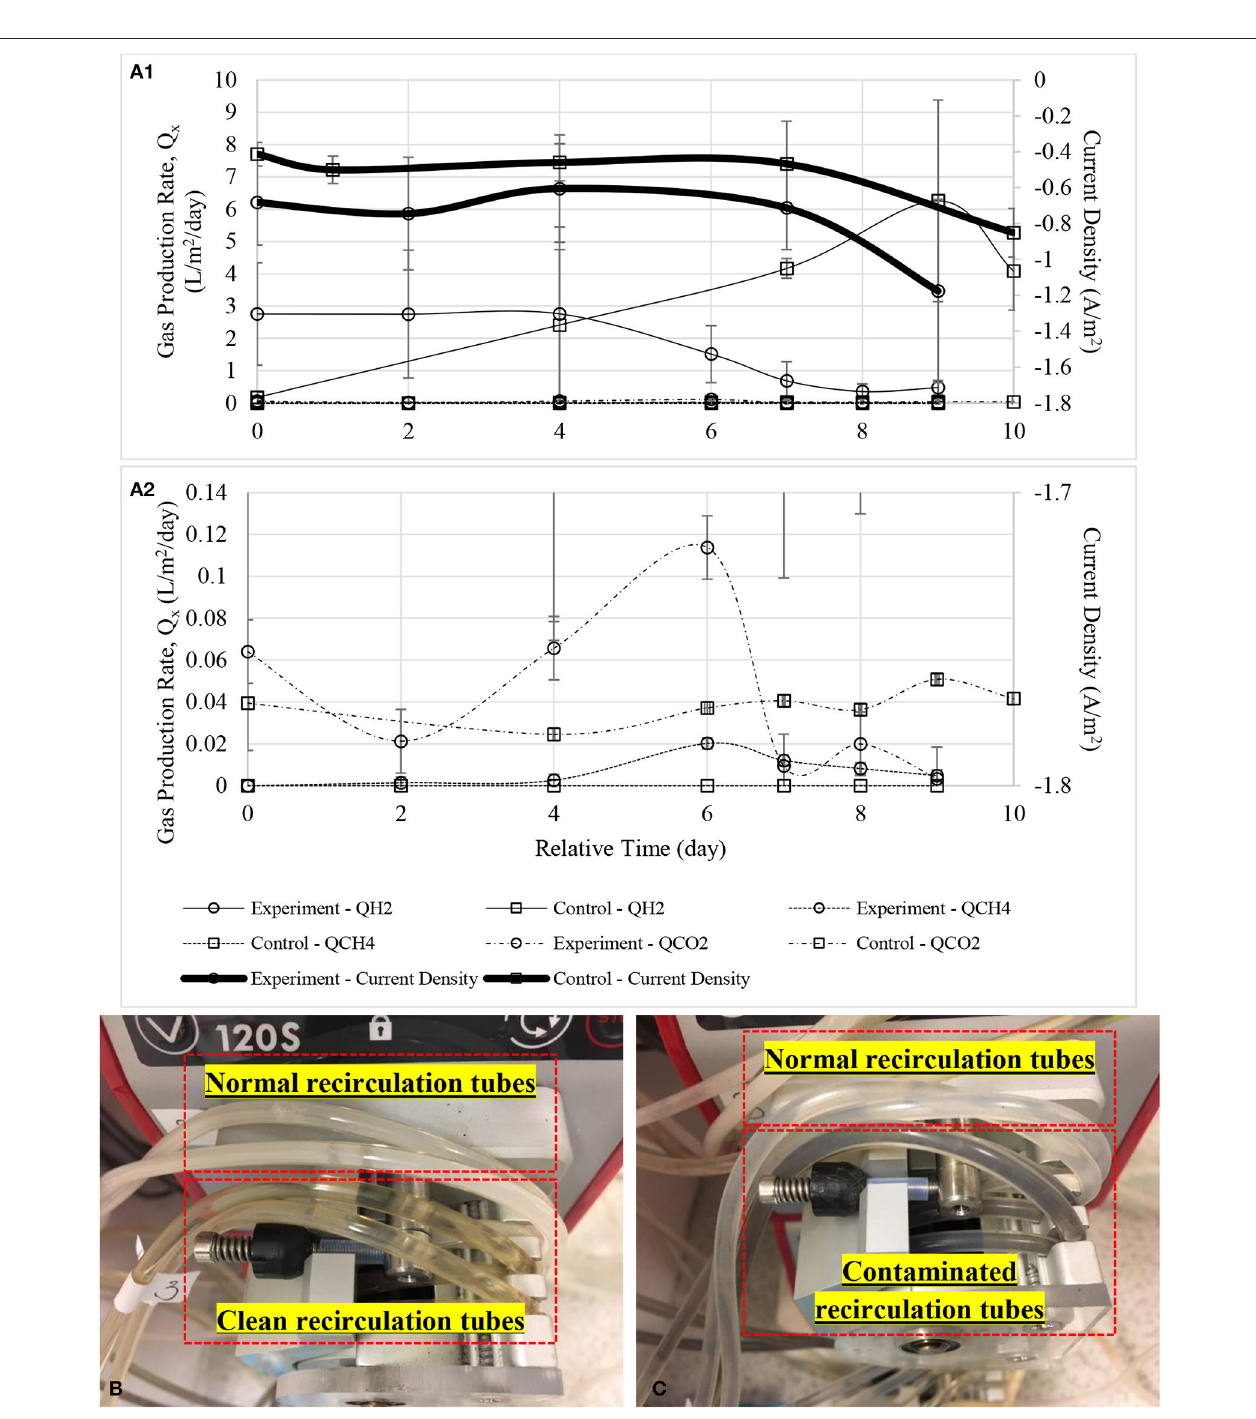
FIGURE 10 | (A1) Gas production rate of the defected MECs with a zoom-in figure (A2) . Noted that hydrogen production dropped dramatically even when CH 4 was first detected at a very low concentration at day 6. Small amount of bicarbonate was probably released as CO 2 or consumed by methanogens. Timeline was adjusted to zero for comparison purpose. (B) Upper tubes show white biofilm grew on the inner surface of the tubes while lower tubes were after cleaned and soaked with disinfectant, Virkon, and (C) upper tubes were the normal biocathode recirculation tubes while black color biofilm was observed in the lower tubes when methane started to detect in gas